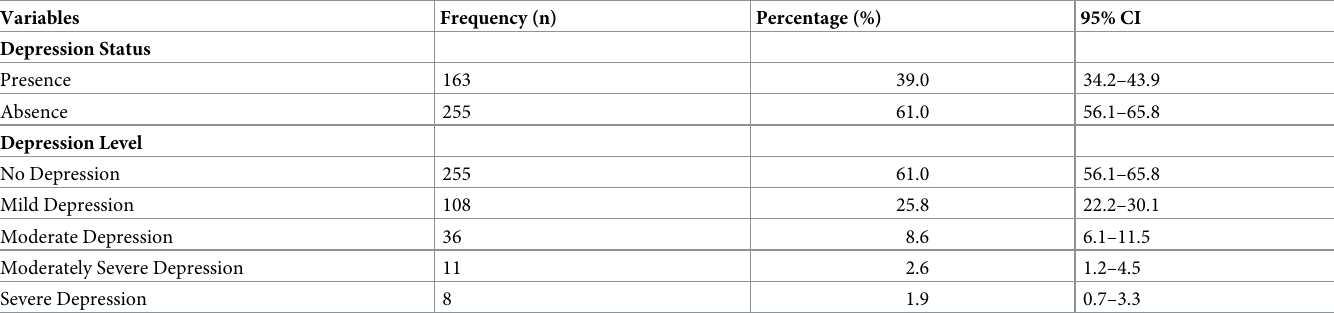
Table 5. Mental distress experienced by the health